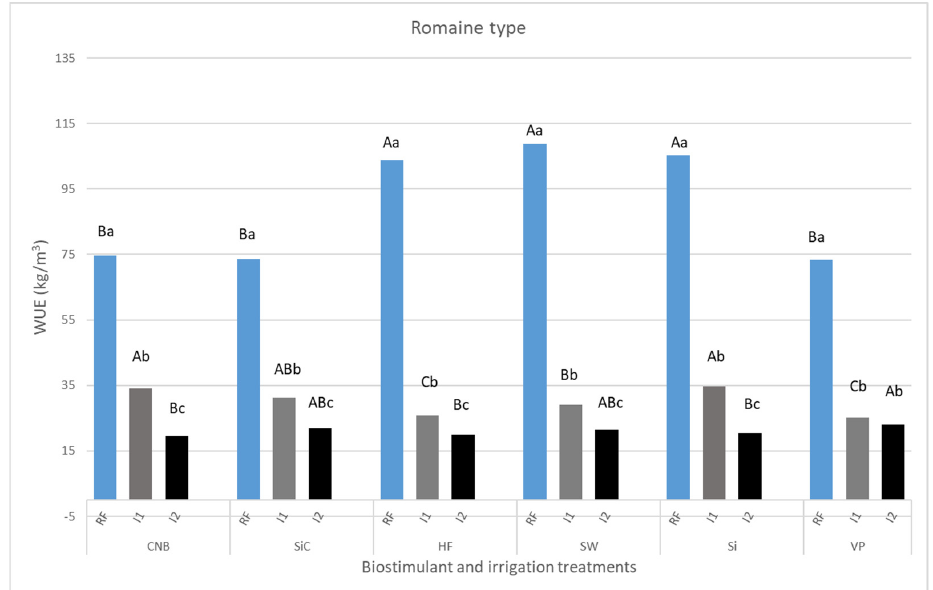
Figure 3. Water use efficiency (WUE) of Romaine-type lettuce plants in relation to biostimulants and irrigation regime. Capital letters above bars indicate significant differences between the means of the same irrigation regime, according to Tukey’s HSD test at p = 0.05. Lowercase letters above bars indicate significant differences between the means of the same biostimulant treatment, according to Tukey’s HSD test at p = 0.05. SW: algae extracts + macronutrients + amino acids; HF: humic + fulvic acids; SiC: Si + Ca; Si: Si; VP: plant proteins + amino acids; C NB : without addition of biostimulants; RF: rain-fed plants; IR.1: 50% of field capacity; IR.2: 100% of field capacity.